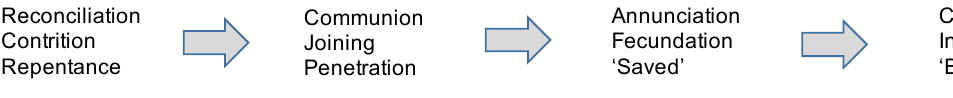
Figure 4. Amalgamating “male” and “female” perspectives ordering annunciation and